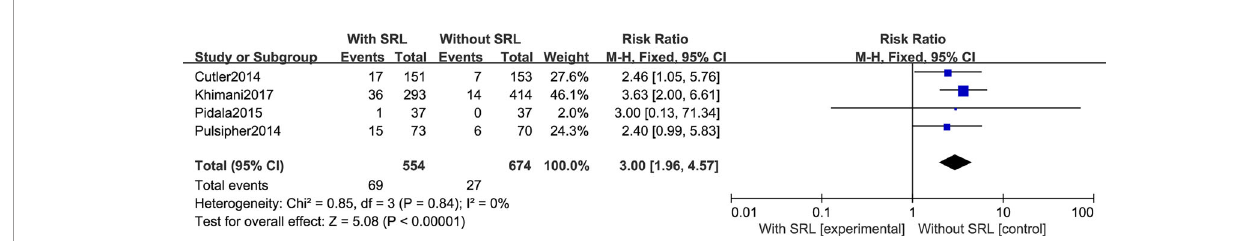
FIGURE 7 | Impact of SRL-based prophylaxis versus non-SRL-based prophylaxis on VOD.